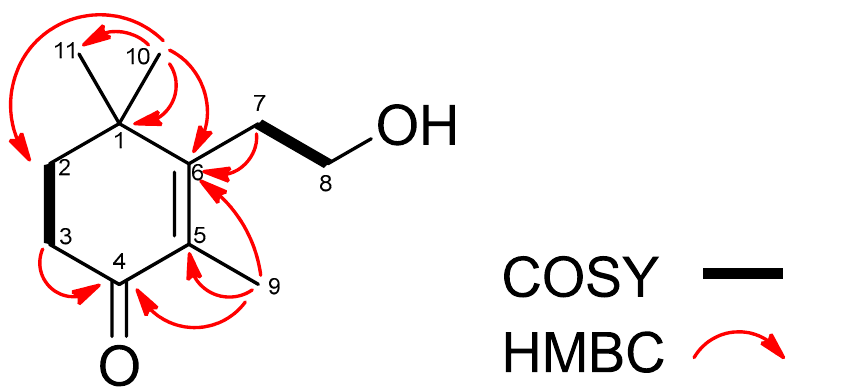
Figure 4. Gross structure of compound 3 or 3-(2-hydroxyethyl)-2,4,4-trimethyl-2cyclohexen-1-one as determined by 2D-NMR spectroscopy.